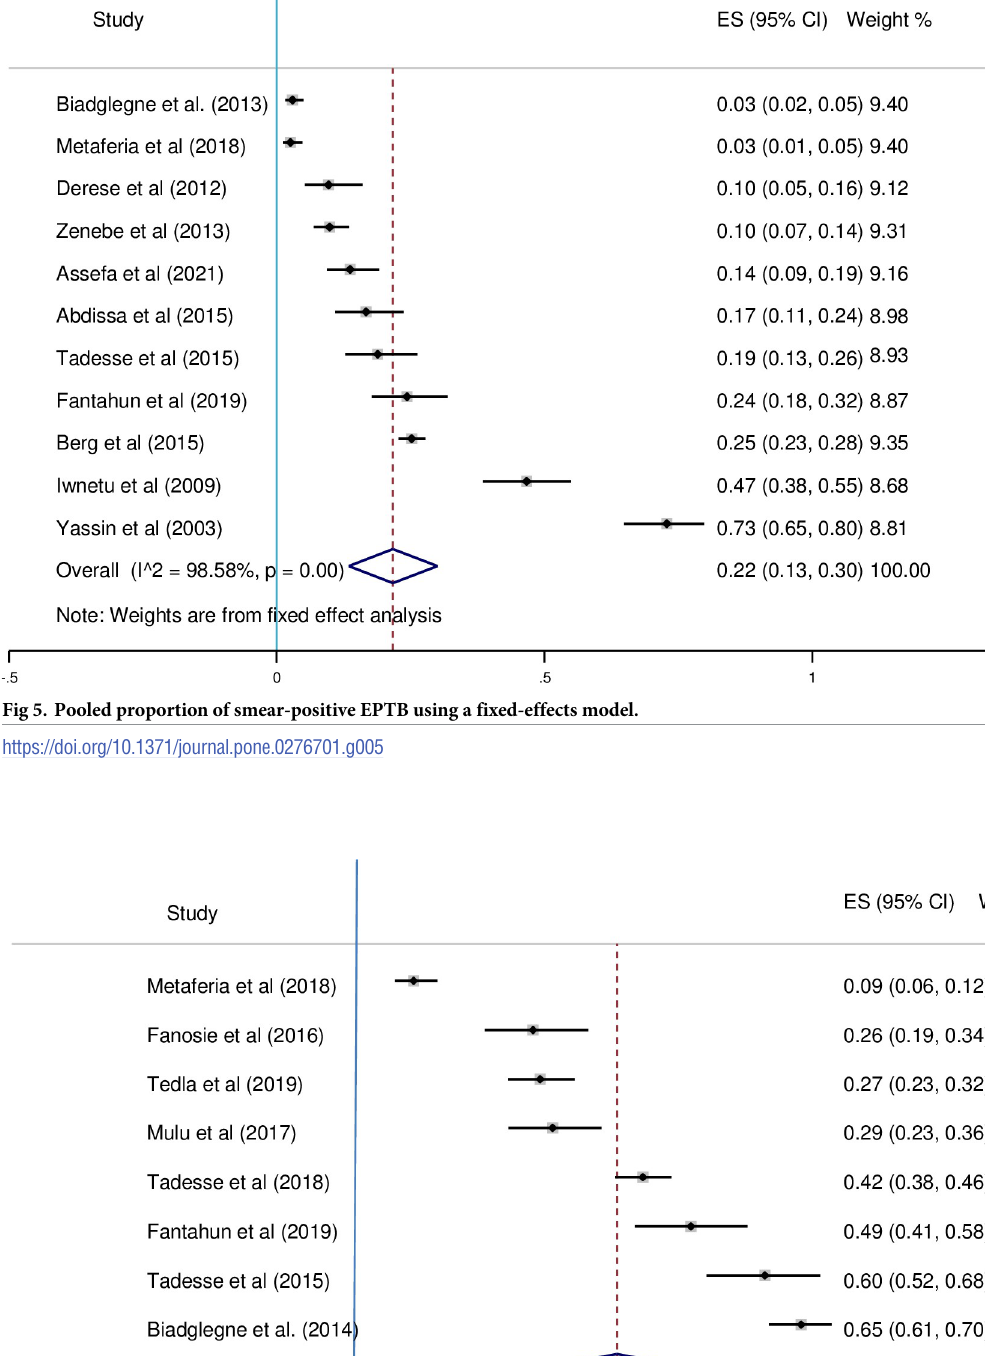
Fig 6. Pooled proportion of Xpert MTB/RIF assay positive EPTB using a fixed-effects model.